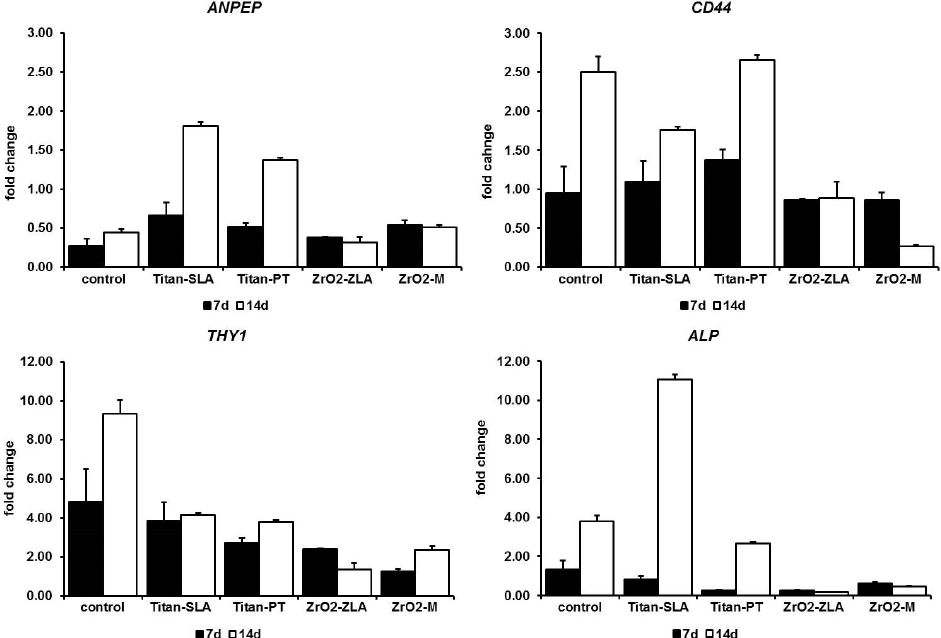
Figure 2. Fold change of stem cell marker compared to day 1 ( ANPEP p = 0.038, CD44 p = 0.18, THY1 p = 0.004, ALP p = 0.17; standard abbreviation as error marks).